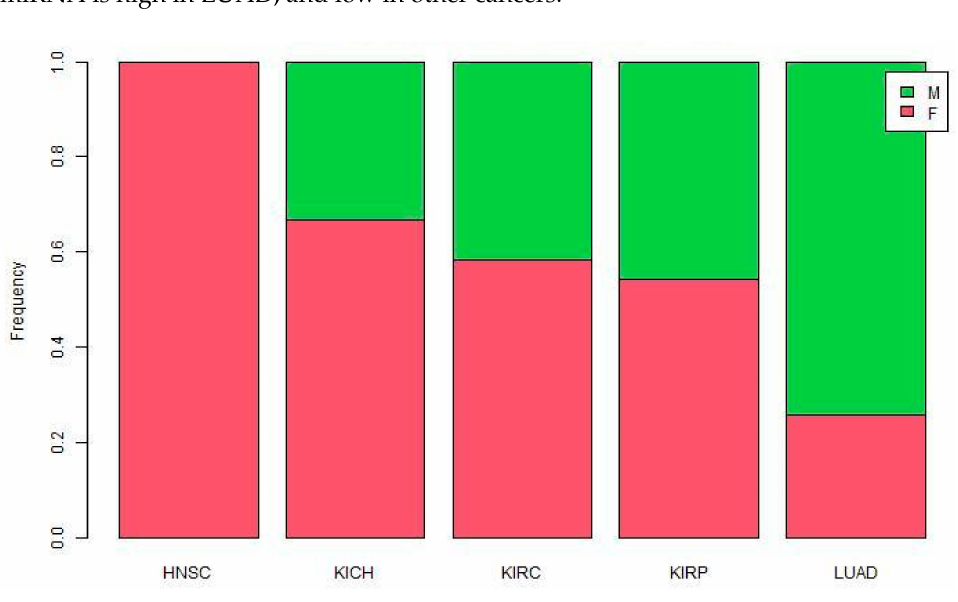
Figure 1. Proportion of sex-biased miRNAs in five TCGA